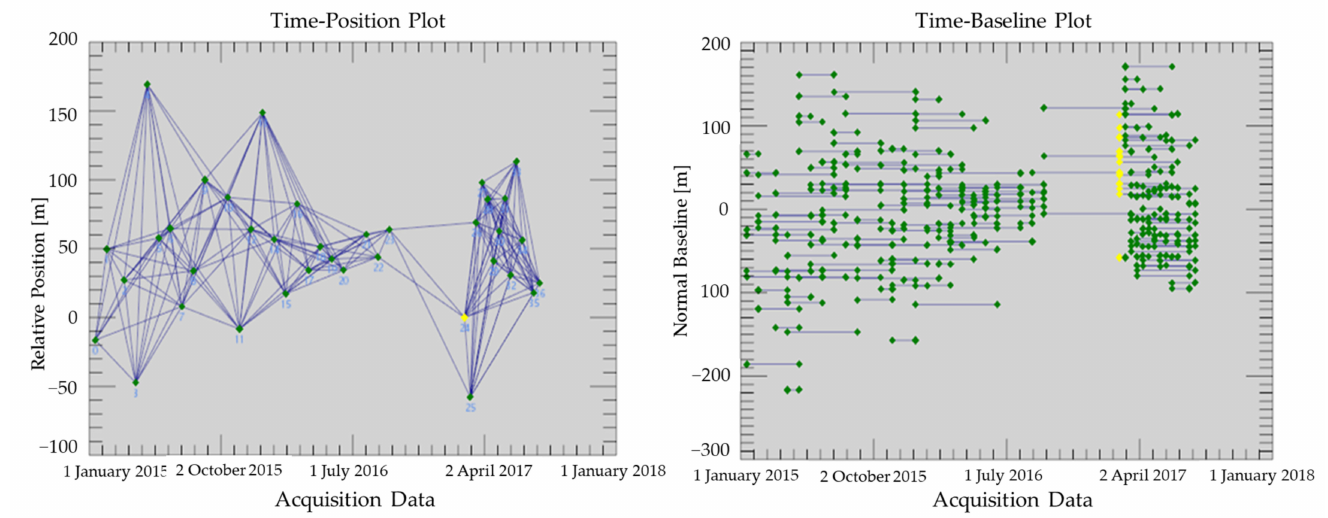
Figure 3. Time-position plot and time-baseline plot of descending orbit